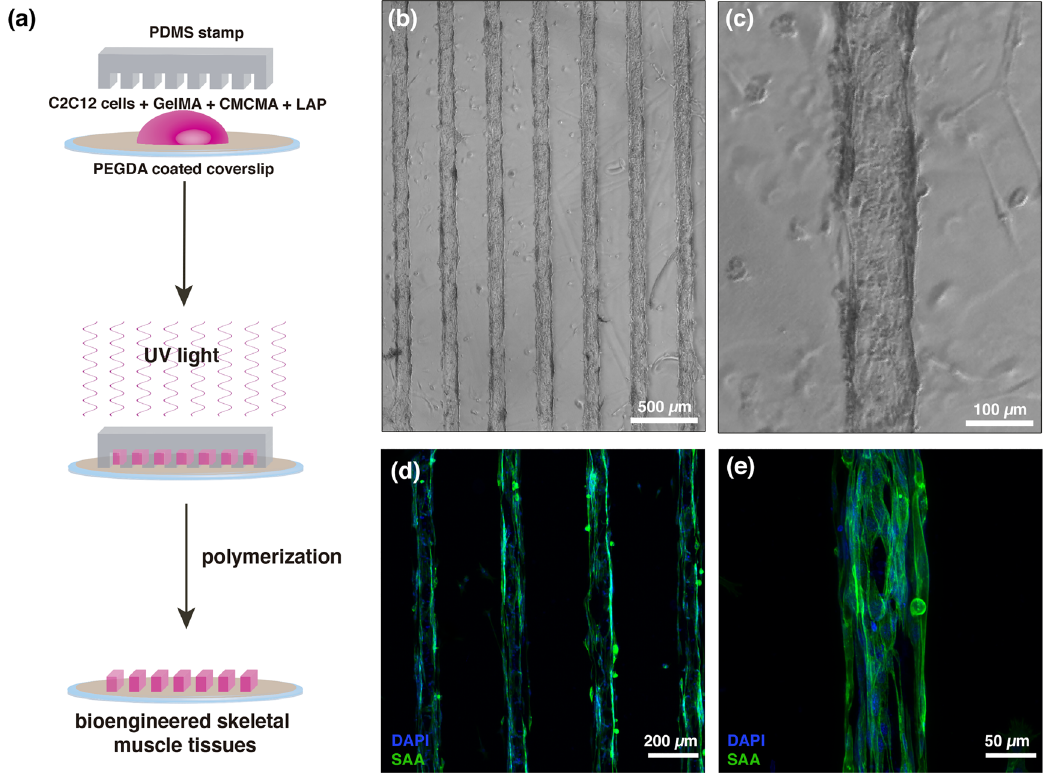
Figure 4: Bioengineered 3D skeletal muscles in GelMA hydrogels. (a) Fabrication protocol to obtain 3D skeletal muscle tissues. hydrogels. A PDMS was used to fabricate cell-laden micropatterned GelMA-CMCMA hydrogels on top of PEGDA-coated glass coverslips by photopolymerization with UV light. (b – c) Microscope images of cell- laden micropatternedhydrogels.(d – e) Representative confocalmicroscopyimages of 3D skeletalmusclemicrotissuesstainedfor themuscle maturation marker sarcomeric α -actinin (SAA, green) and nuclei (DAPI, blue) after 10 days in differentiation